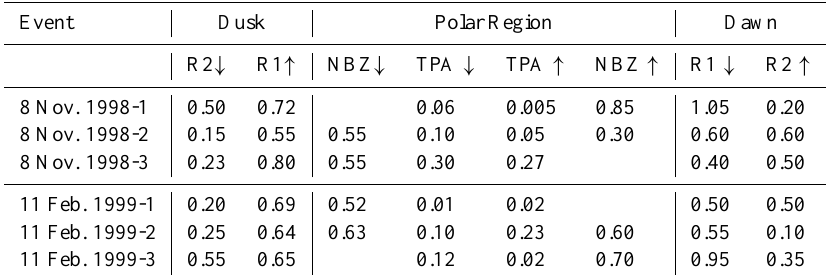
Table 1. Modelled field-aligned current values